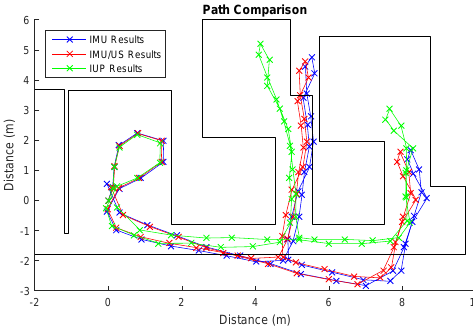
Figure A4. The tracked walking paths by the inertial measurement unit (IMU), IMU/ultrasound (US) and inertial/ultrasound/particle filter (IUP) systems for trial 3 of Type 2